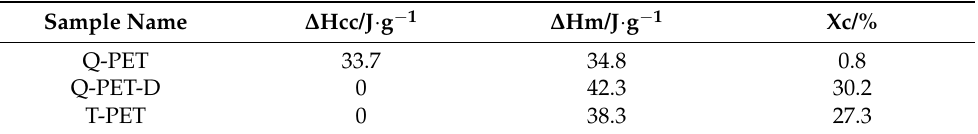
Table 1. DSC enthalpies and crystallization data for Q-PET before and after the treatment (Q-PET-D) and